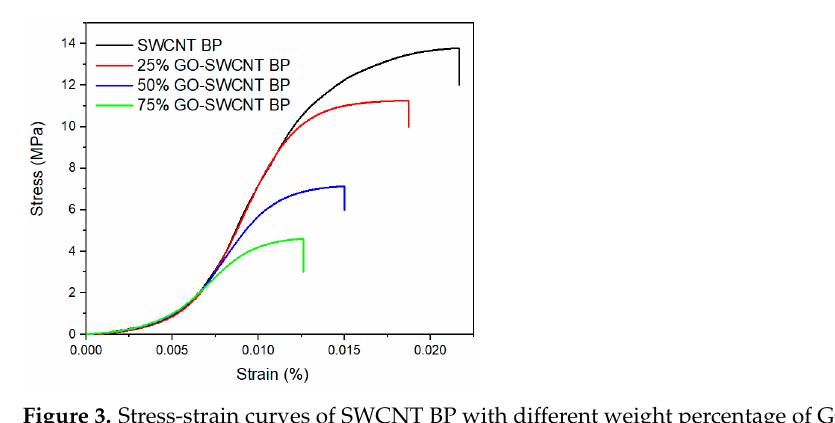
Figure 2. SEM images of ( a ) SWCNT BP, ( b ) 25% GO-SWCNT BP, ( c ) 50% GO-SWCNT BP, and ( d ) 75% GO-SWCNT BP, showing the presence of GO flakes homogeneously embedded in the SWCNT BP network.